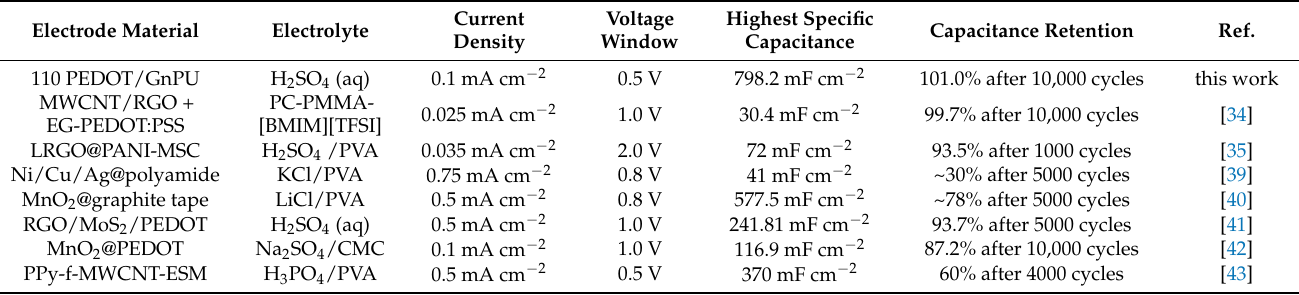
Table 2. Comparison of areal specific capacitance values of some other existing